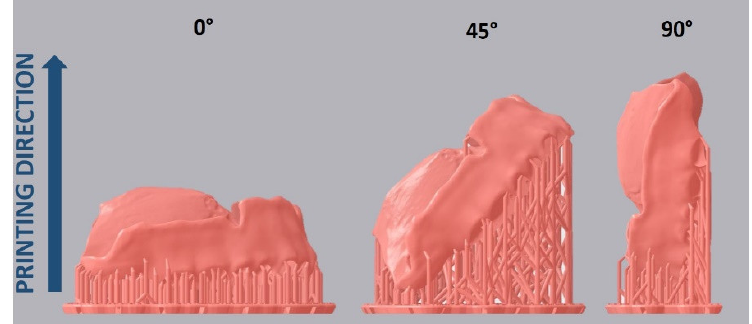
Figure 1. Nesting with three alternative build angles used in the study.